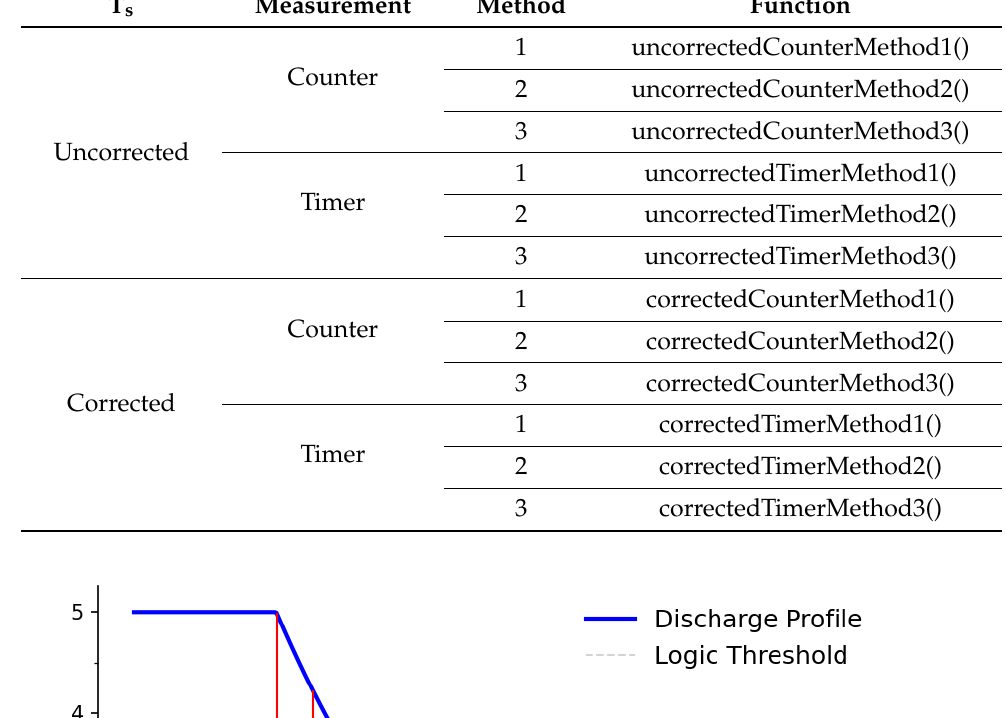
Table 1. Lookup table for identifying the appropriate function in the ESI ‘firmware.ino’ file.